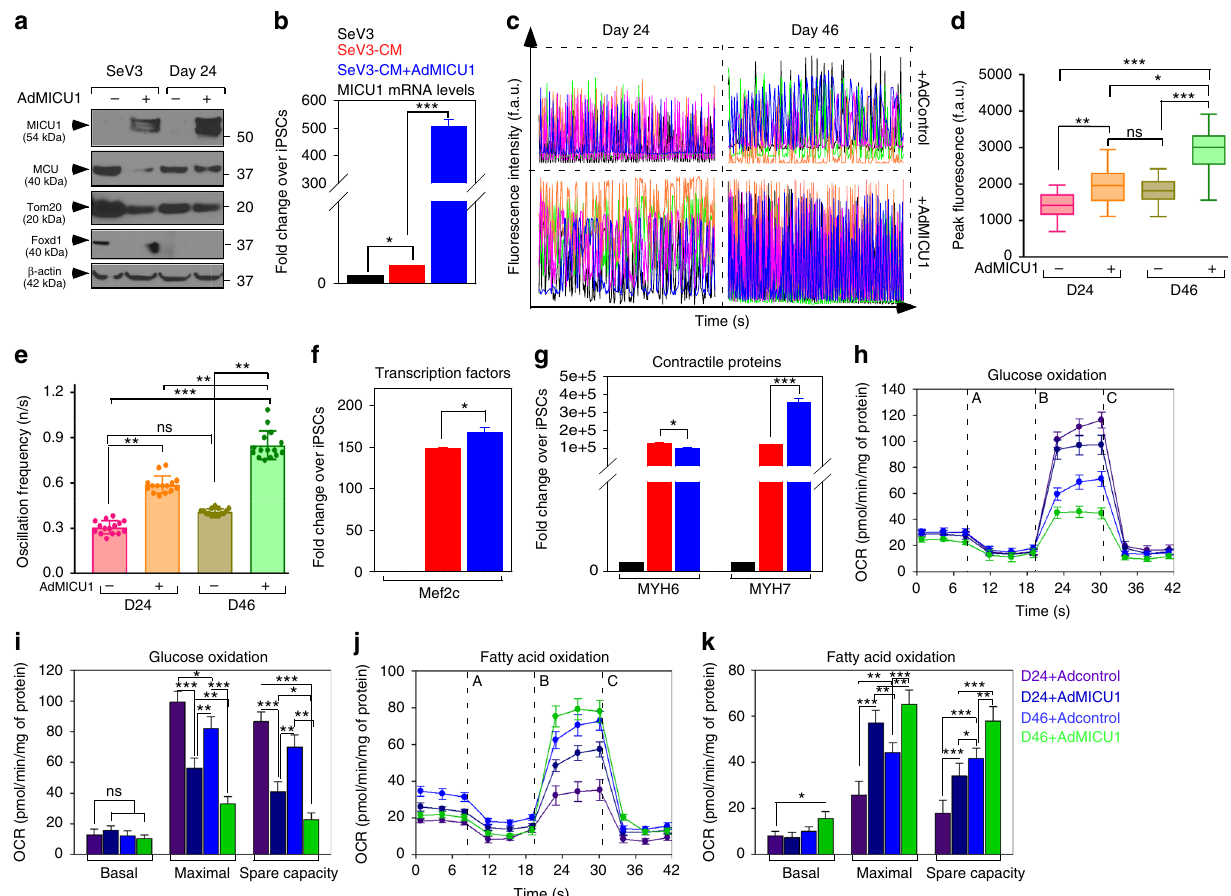
Fig. 5 MICU1 expression promotes iPSC-Cardiomyocyte maturation. a Representative western blot for lysates from SeV3 and SeV3-derived cardiomyocytes (SeV3-CMs) with and without MICU1 expression. The western blots were probed with antibody speci fi c for MICU1, MCU, Foxd1, Tom20, and β -actin. b Quanti fi cation of the MICU1 mRNA abundance in SeV3 and day 24 SeV3-CMs. c Traces of spontaneous cytosolic Ca 2 + oscillations in SeV3- CMs with and without MICU1 expression at day 24 and day 46 post-differentiation. d Quanti fi cation of peak fl uo-4 fl uorescence. e Quanti fi cation of the frequency of c Ca 2 + oscillations. Data indicate Mean ± SEM; ** P < 0.001, *** P < 0.001; n = 3 – 4 independent experiments. Dots represents data from group of single cells. f Quanti fi cation of mRNA abundance of the early cardiac transcription factor Mef2c in SeV3-CMs with or without MICU1 expression at day 24 of differentiation. g Quanti fi cation of mRNA abundance of the cardiac contractility proteins, MYH6, and MYH7 in SeV3-CMs with or without MICU1 expression at day 24 of differentiation. Data indicate Mean ± SEM; * P < 0.05, *** P < 0.001; n = 3 – 4. h , j Measurement of oxygen consumption rate (OCR) in SeV3-CMs with or without MICU1 expression using glucose (glucose oxidation) ( h ) or carnitine (fatty acid oxidation) ( j ) as substrate (glucose oxidation). After basal OCR measurement, oligomycin (A), FCCP (B), and rotenone + Antimycin A (C) were added as indicated. h , j Representative traces of OCR in SeV3-CMs. i , k Quanti fi cation of basal and maximal OCR, and spare capacity in SeV3-CMs. Data indicate Mean ± SEM; * P < 0.05, ** P < 0.01, *** P < 0.0001; n